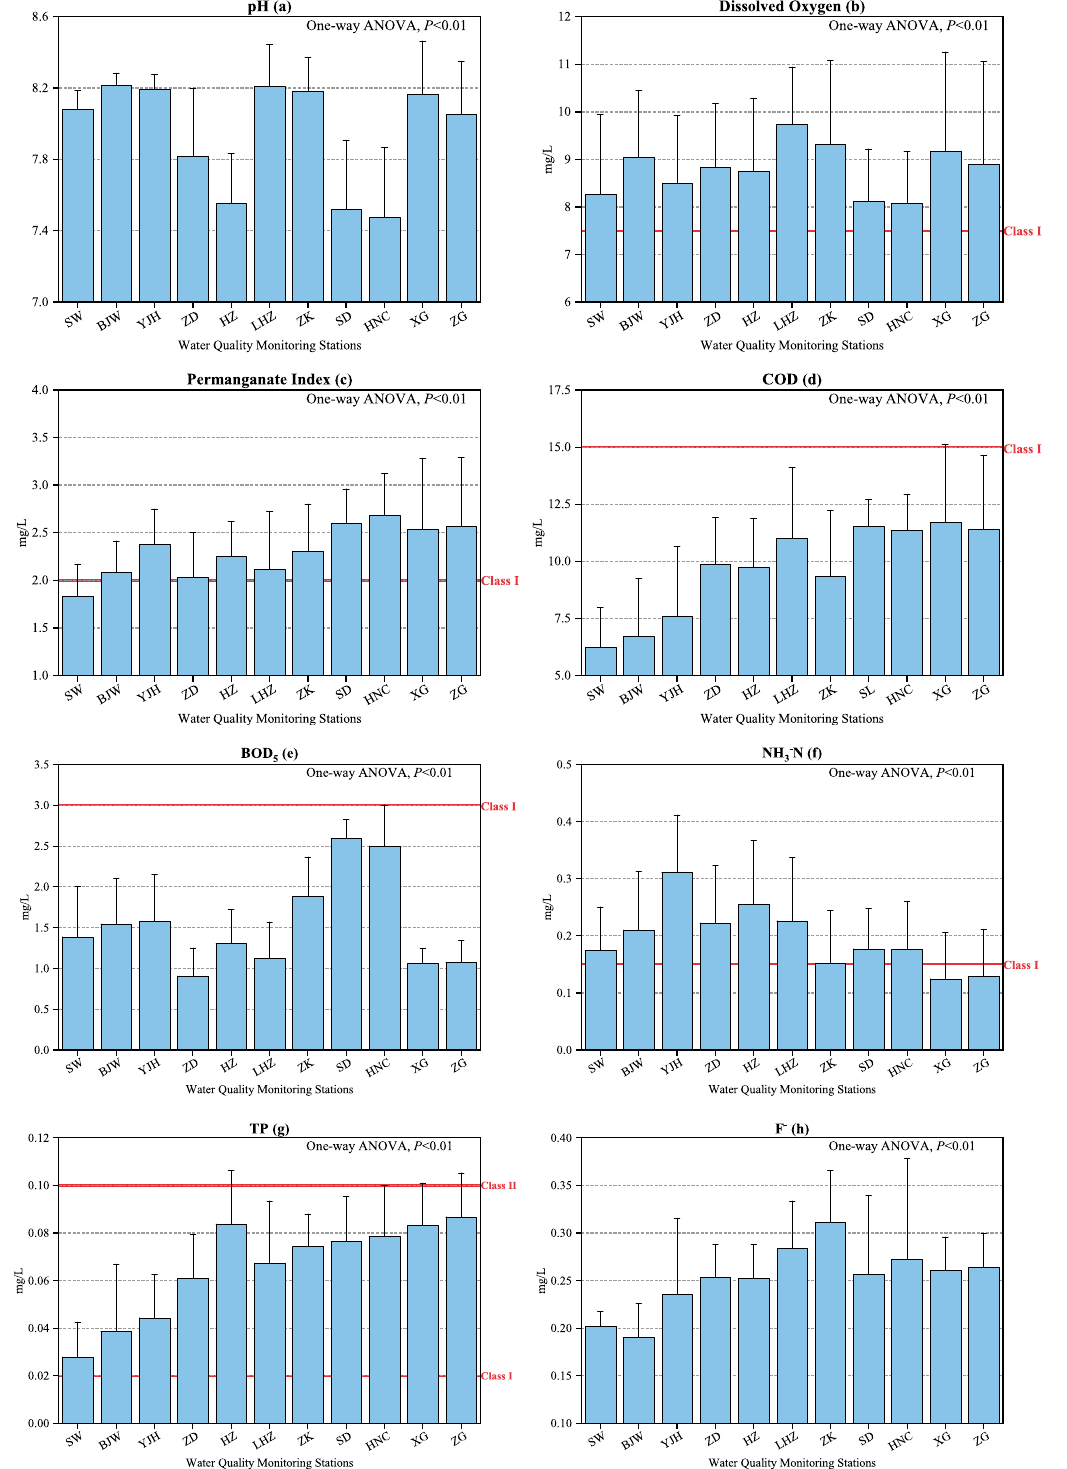
Figure 2. Average and standard deviation of concentration for 15 water quality parameters at each monitoring station during the year 2015 ~